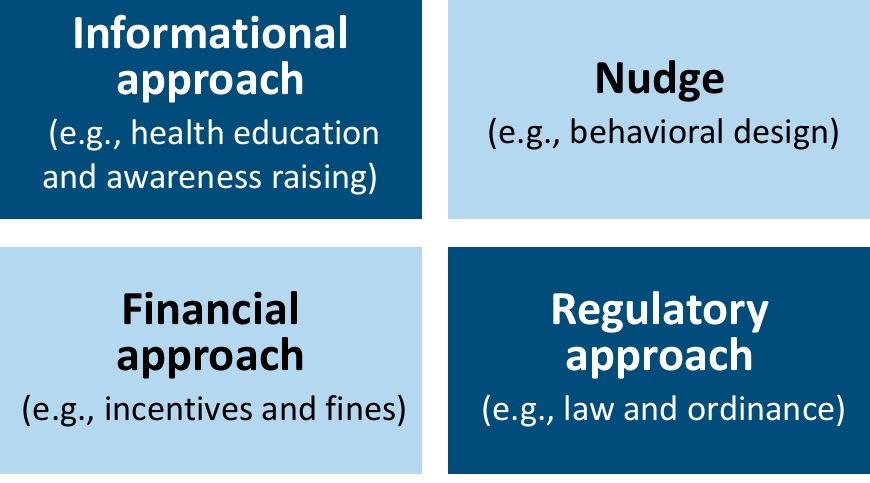
Figure 1. Multiple tools for policy implementation.